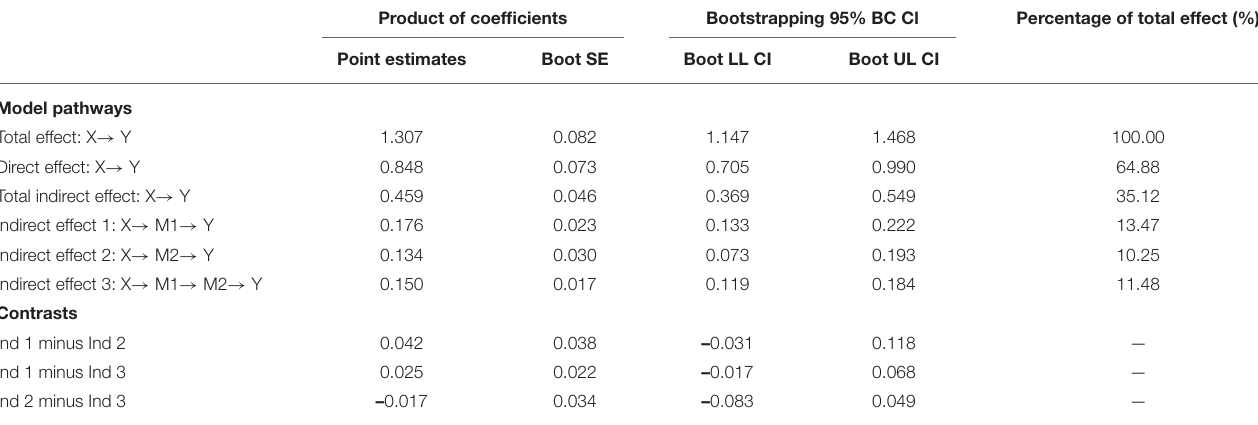
TABLE 5 | Comparison of indirect effects of sickness presenteeism on health-related productivity loss mediated by fatigue and job burnout ( N =